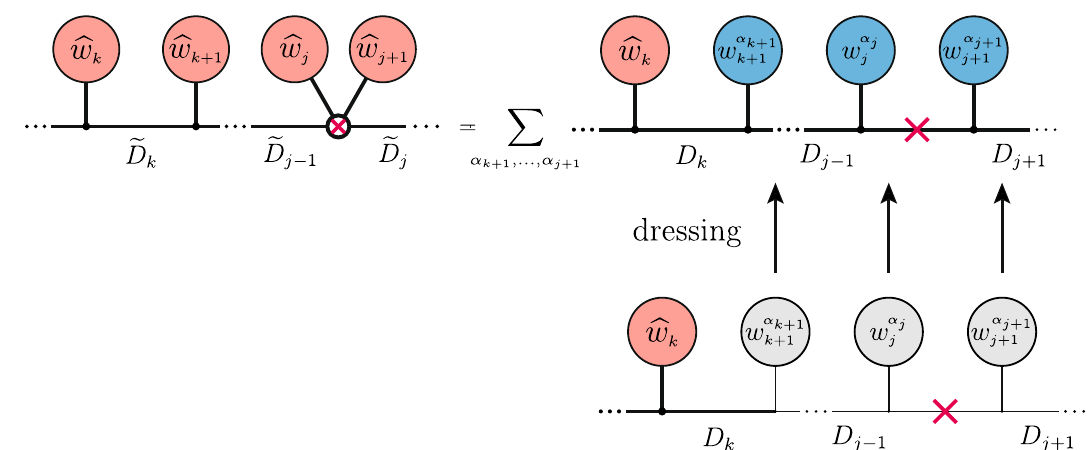
Fig. 9 Required dressing (89) and relabeling (87) operations before merging open loops with an undressed pinched propagator ¯ D